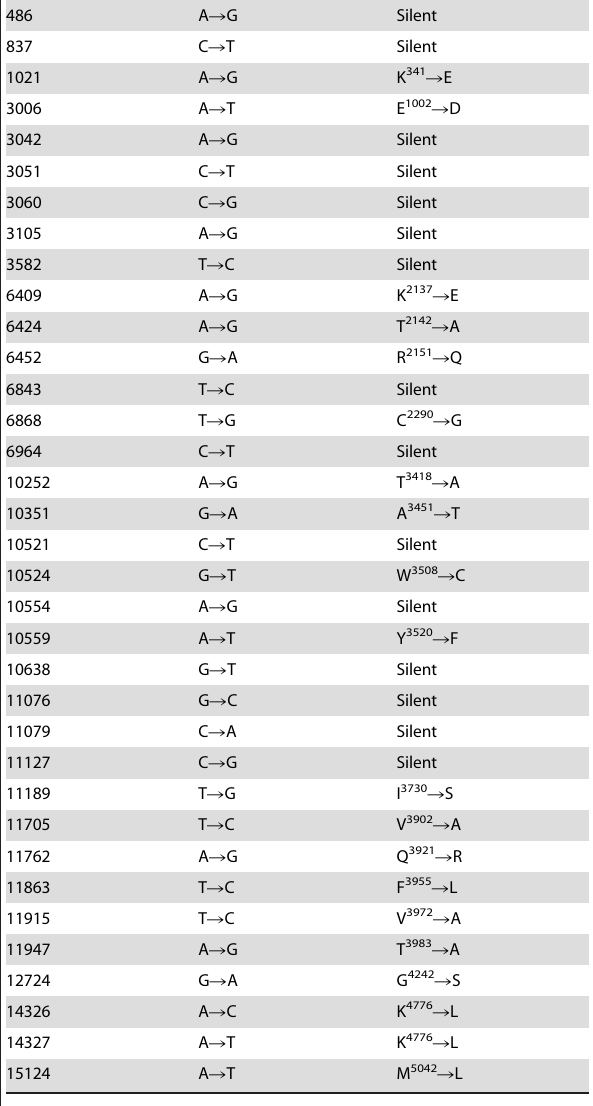
Nucleotide position* Nucleotide exchange Amino acid exchange